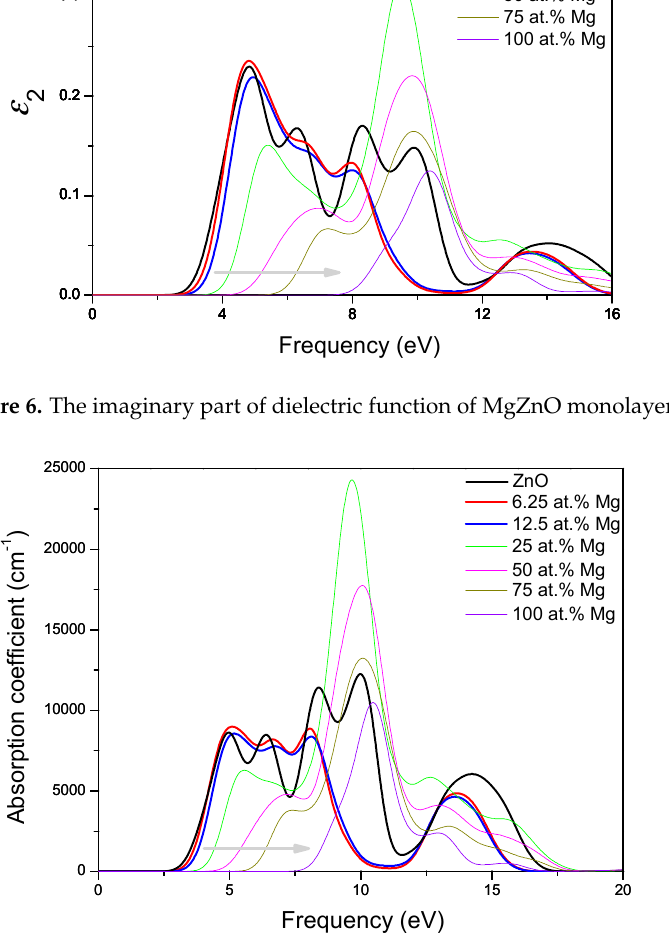
Figure 7. The absorption coefficient of MgZnO monolayer.